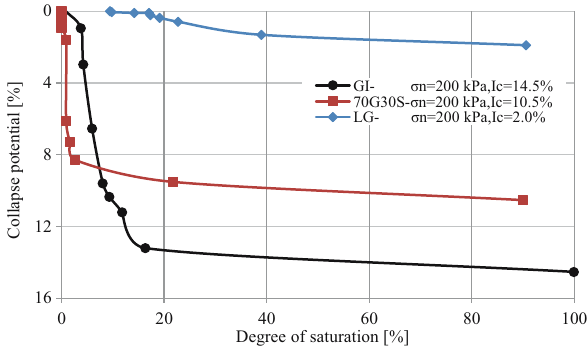
Figure 8: Variation of the collapse potential with degree of satura - tion of the ( CN - SD ) wetting